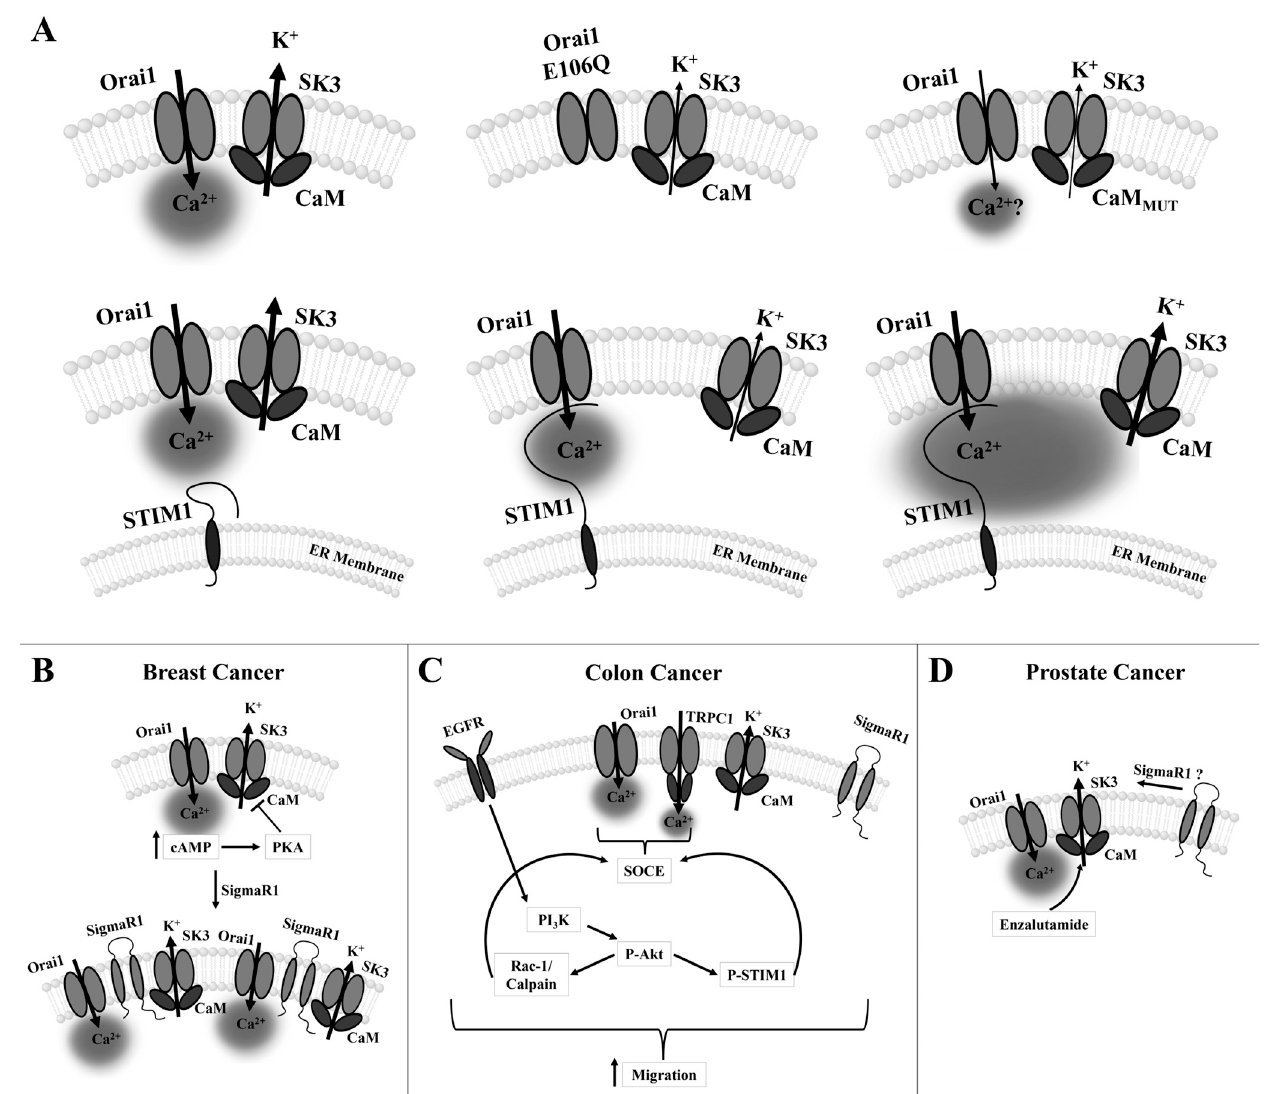
Figure 8. The Orai1/SK3 interplay and methods of its modulation in breast, colon, and prostate cancer. ( A ) Generally, the co-localization of Orai1 and SK3 channels is sufficient for their interplay, which leads to a positive feedback mechanism. Orai1 E106Q pore mutant does not affect its co-localization with SK3 but is unable to boost SK3 K + currents. CaM MUT, which typically abolishes SK3 K + currents, can be rescued by co-localized Orai1. In the presence of STIM1, the SK3–Orai1 interplay remains unaffected in the resting state, and upon store-depletion, STIM1 binds to Orai1 and thus moves SK3 and Orai1 apart from each other. Local enhancements of Ca 2+ due to STIM1-mediated Orai1 activation do not boost SK3 K + currents, whereas global Ca 2+ enhancements strongly augment SK3 K + currents. ( B ) In breast cancer cells, the interplay of Orai1 and SK3 boosts metastasis, which can be modulated by the cAMP-PKA pathway (adapted from Clarysse et al. (2014) [322]). Additionally, the stress-activated chaperone SigmaR1 promotes the interplay of Orai1 and SK3 in breast cancer cells (adapted from Gueguinou et al. (2017) [321]). ( C ) In colon cancer cells, migration is promoted by SOCE via a complex of TRPC1, Orai1, and SK3. This involves the activation of the Akt pathway